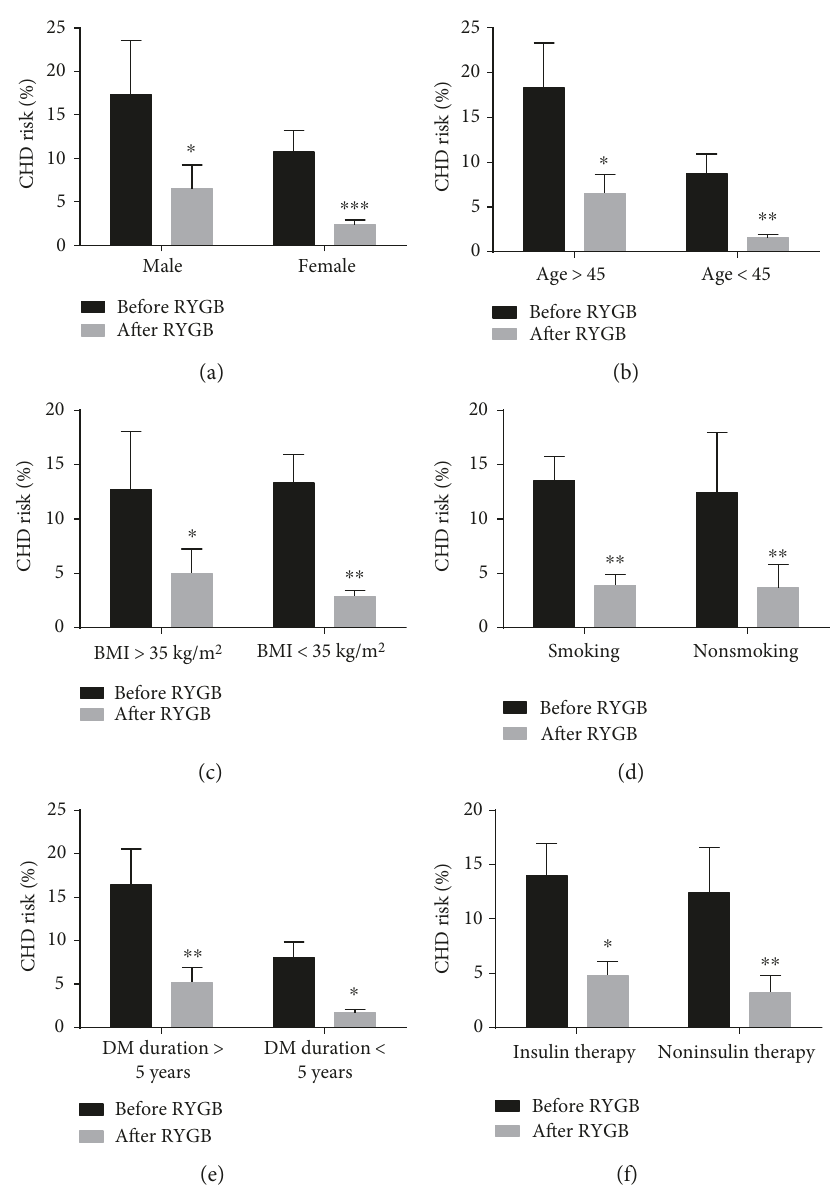
Figure 1: Changes of 10-year coronary heart disease (CHD) risk before and after RYGB surgery in di ff erent subgroups divided by gender, age, BMI, smoking status, DM duration, and insulin usage (baseline versus 18 months). (a) Male versus female; (b) age ≥ 45 years old versus < 45 years old; (c) BMI < 35kg/m 2 versus BMI ≥ 35 kg/m 2 ; (d) smoking versus nonsmoking; (e) DM duration ≥ 5 years versus DM duration < 5 years; and (f) insulin usage versus noninsulin usage. Data represent means ± SEM. ∗ P < 0 05 , ∗∗ P < 0 01 , and ∗∗∗ P < 0 001